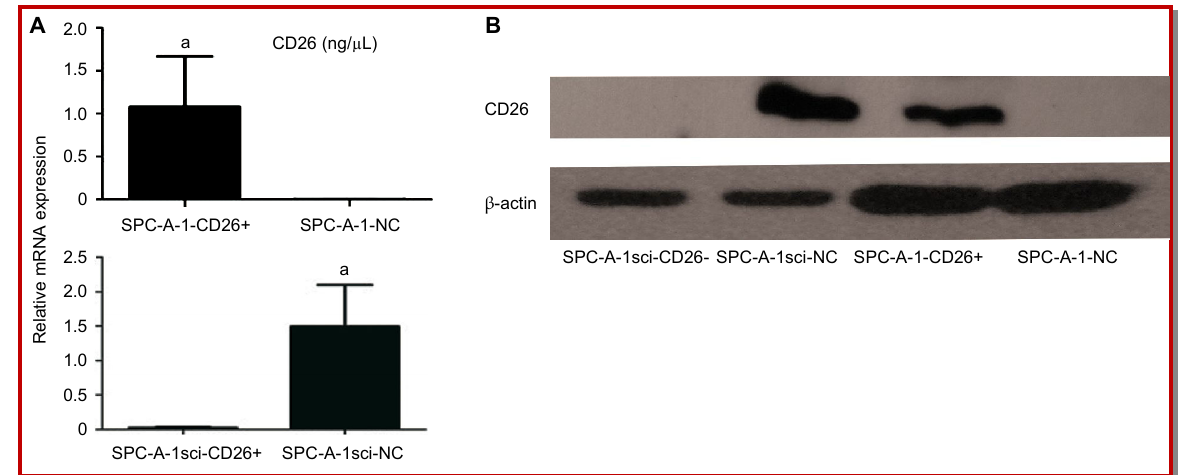
Figure 1: Expression of CD26 in transfected lung cancer cells. (A) Quantitative-PCR analysis of the CD26 mRNA levels in transfected cells. The results are expressed as the mean ± SD; a p<0.01. (B) Detection of CD26 in transfected cells by immunoblotting. (cid:451) - actin was used as a loading